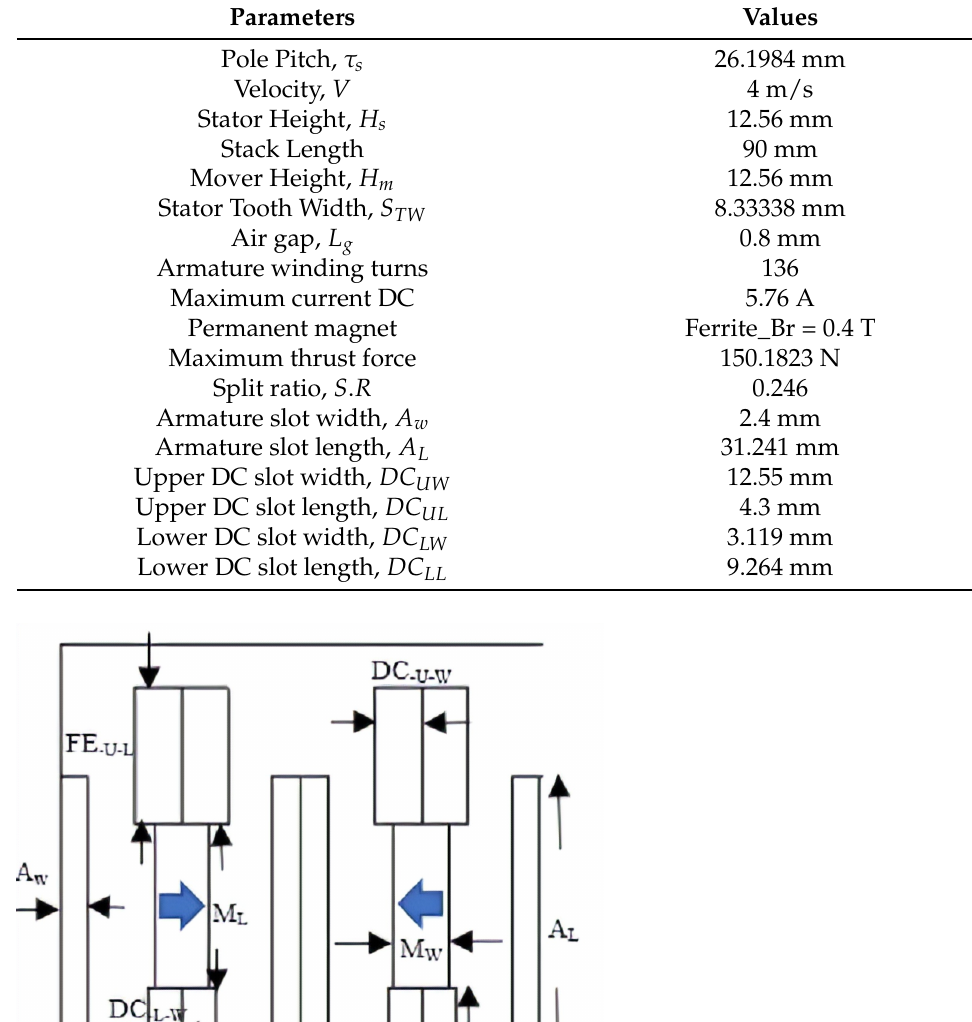
Table 1. Detailed parameters of the proposed model.